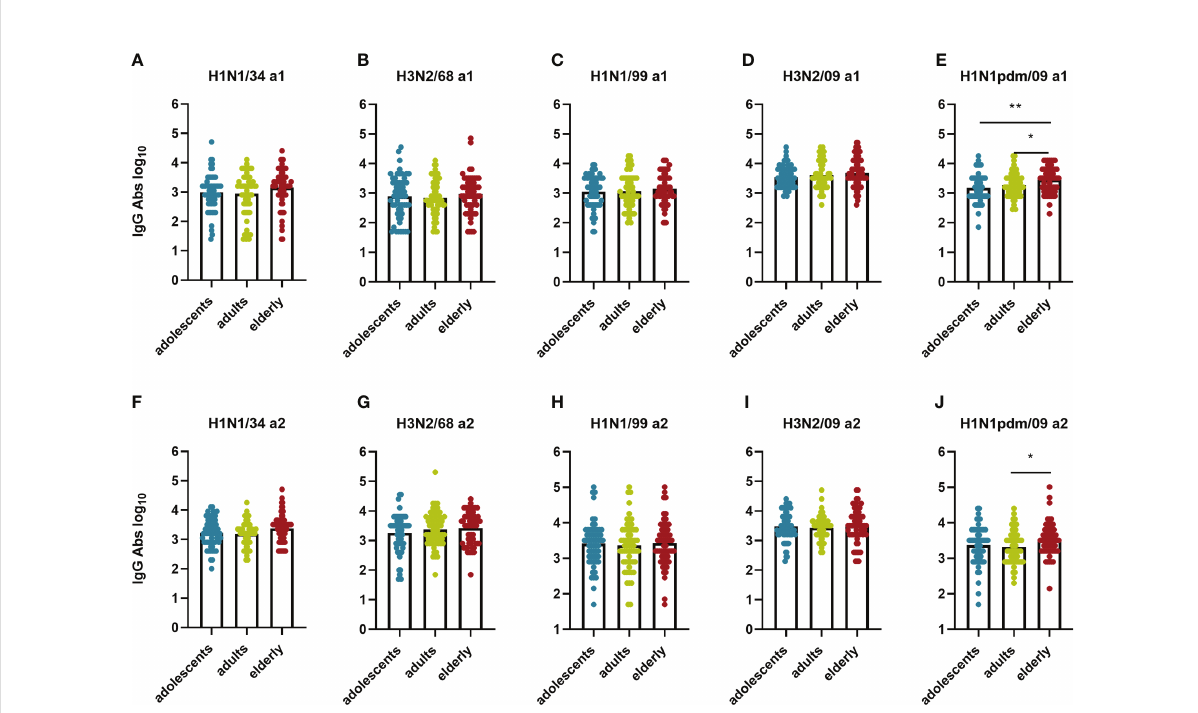
FIGURE 6 Birth year-related differences in IgG titers per virus strain. IgG titers measured in the different age groups for each of the 5 in fl uenza virus strains at a1 (A – E) and a2 (F – J) are displayed. Data were analyzed using Kruskal Wallis test followed by Dunn ’ s post-hoc test for multiple comparison. *P ≤ 0.05; **P ≤